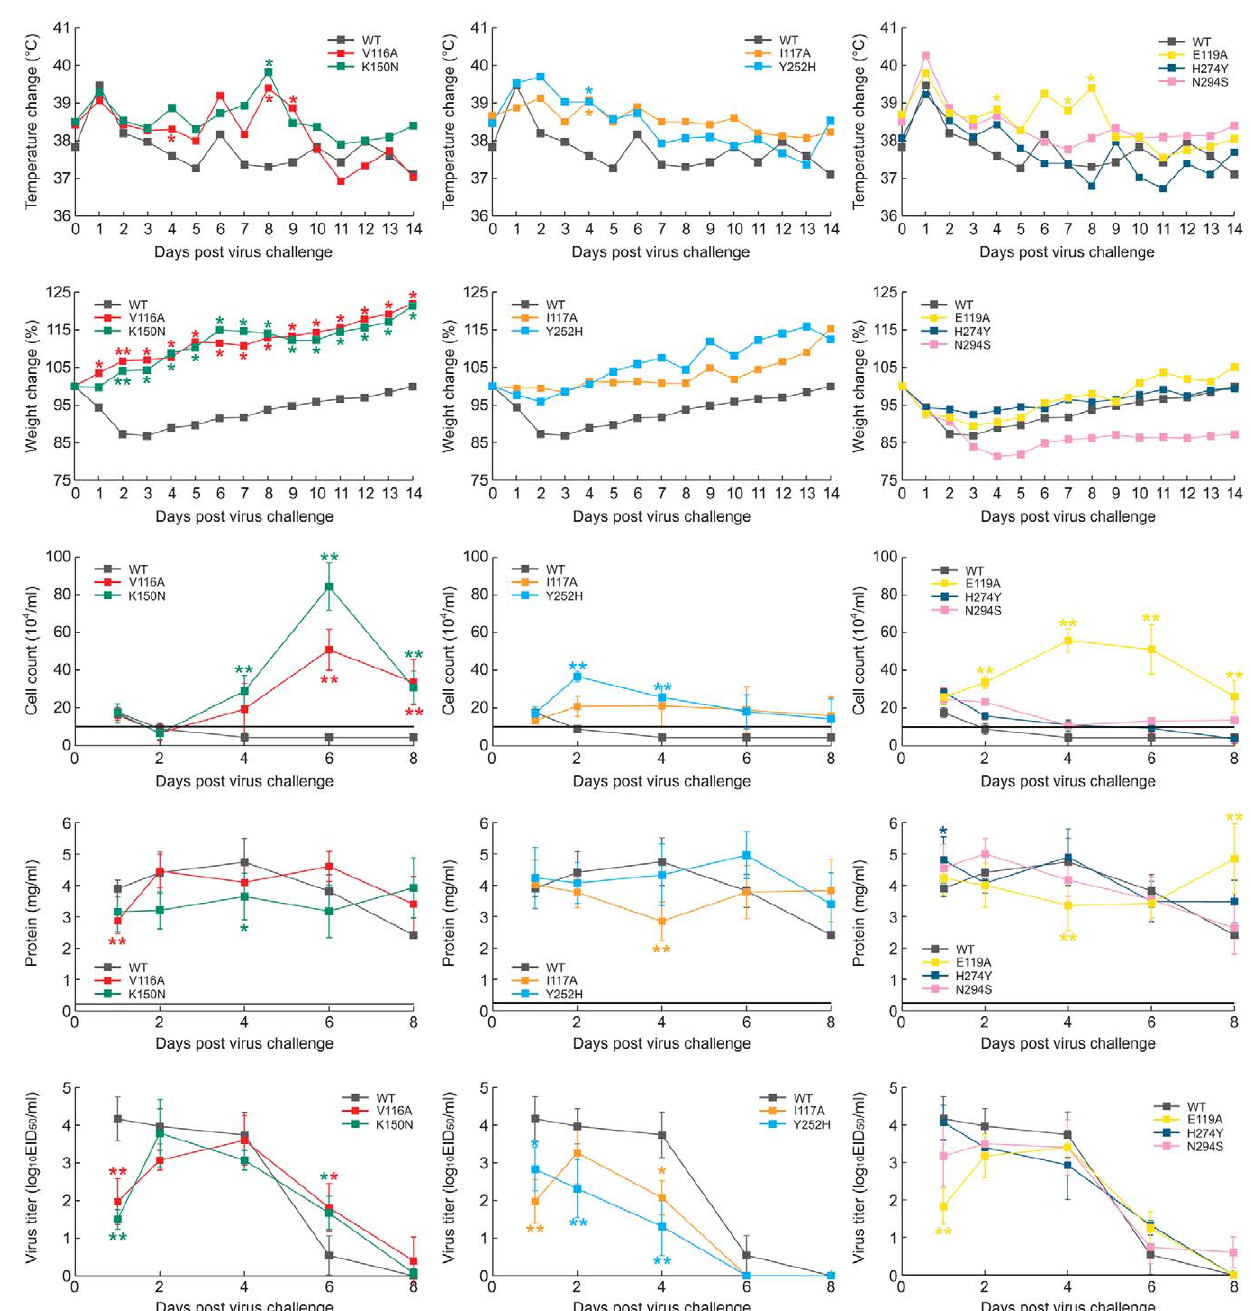
Figure 3. Patterns of clinical outcome in ferrets inoculated with the recombinant A/Turkey/15/06-like (H5N1) viruses. (A) Mild, prolonged illness, (B) mild, brief illness, and (C) severe illness or (comparable to WT) caused by the indicated recombinant viruses. Shown are change in body temperature and weight, total number of inflammatory cells and protein concentrations in nasal washes, and virus titers in the upper respiratory tract. The horizontal lines show the mean inflammatory cell counts and protein concentrations in the nasal washes of uninoculated animals. Values are the mean 6 s.d. for three ferrets. The mean s.d. of all data points for change in body temperature and weight was , 6 4.5%. *, P , 0.05, **, P , 0.01 compared to WT virus (one-way